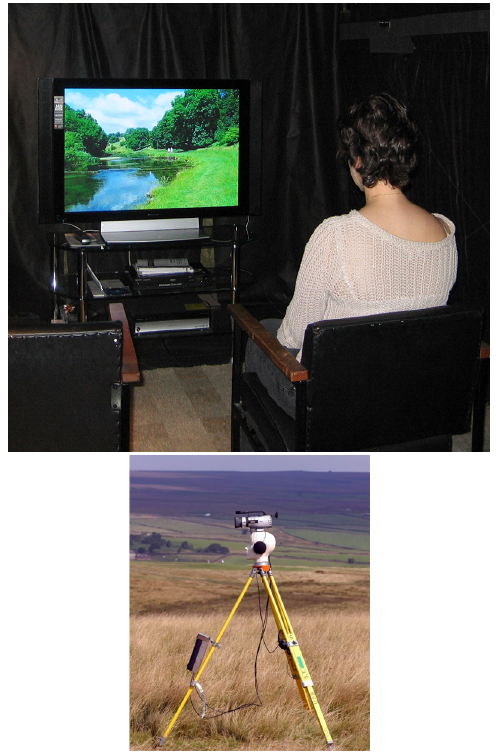
Figure 1: Experimental subject rating a video clip taken using “Ma- rina”